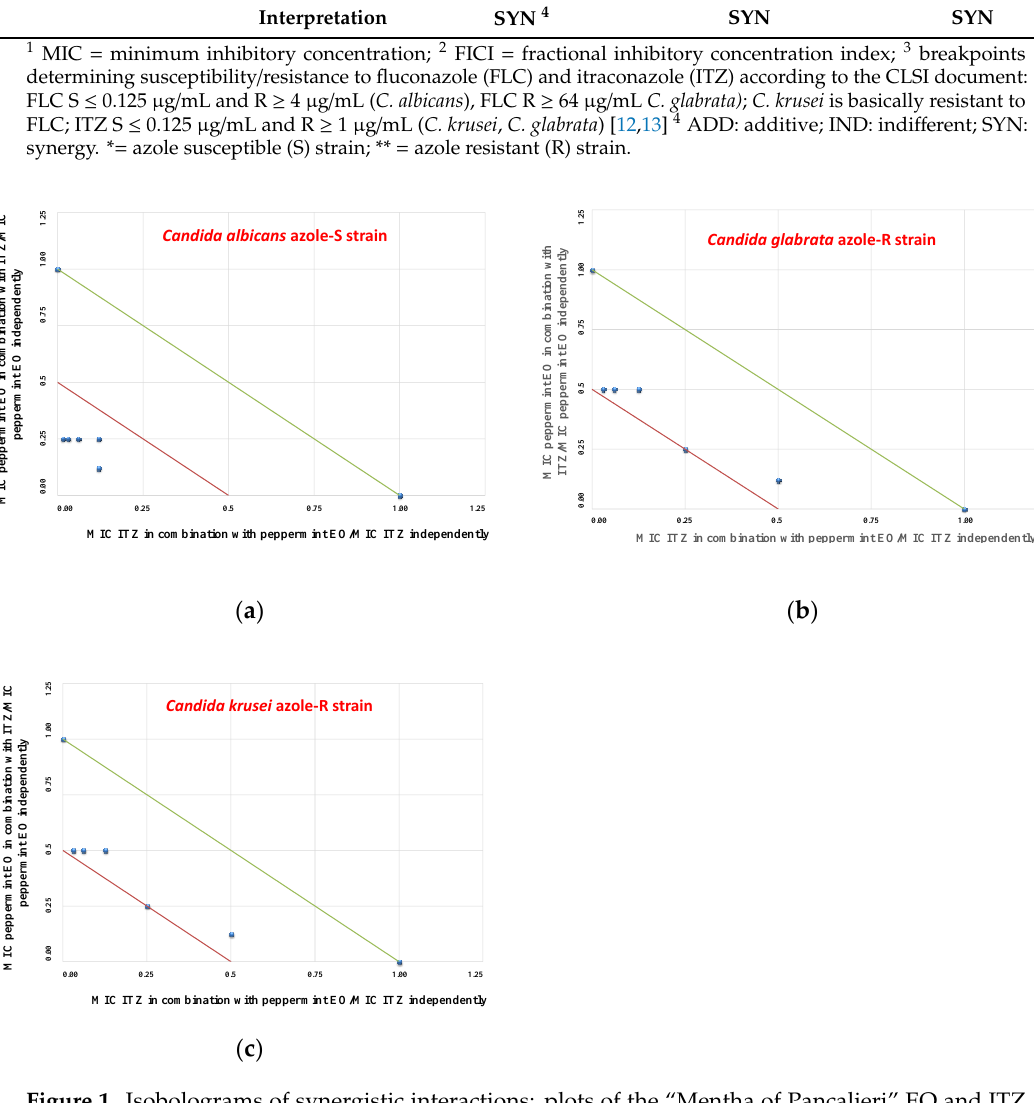
Figure 1. Isobolograms of synergistic interactions: plots of the “ Mentha of Pancalieri ” EO and ITZ against Candida spp. (azole-susceptible/resistant strains). ITZ FIC data are drafted on the x-axis, while EO FIC values are drafted on the y-axis: ( a ) isobologram plot of EO and ITZ against the Candida albicans azole-S strain; ( b ) isobologram plot of EO and ITZ against the Candida glabrata azole-R strain; ( c ) isobologram plot of EO and ITZ against the Candida krusei azole-R strain.